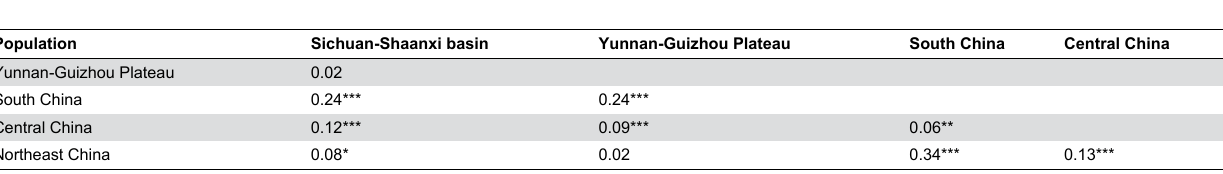
values between different ST